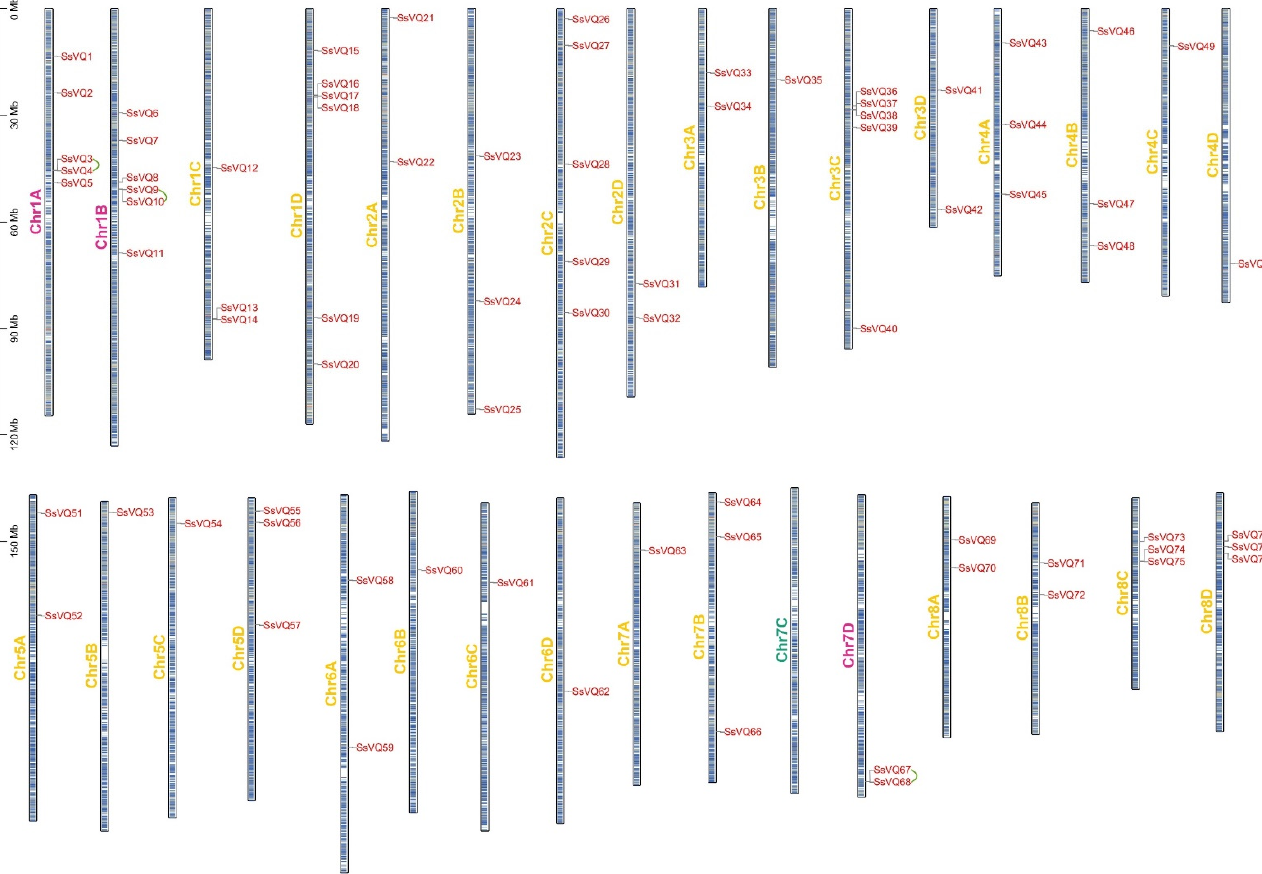
Figure 4. Schematic representations for the chromosomal distribution of S. spontaneum VQ genes. A green line between the two gene names indicated that they were tandem repeat gene pairs. The chromosome number was indicated to the left of each chromosome. SsVQ gene numbers are shown on the right of each chromosome. Scale bar on the left indicates the chromosome lengths (Mb).